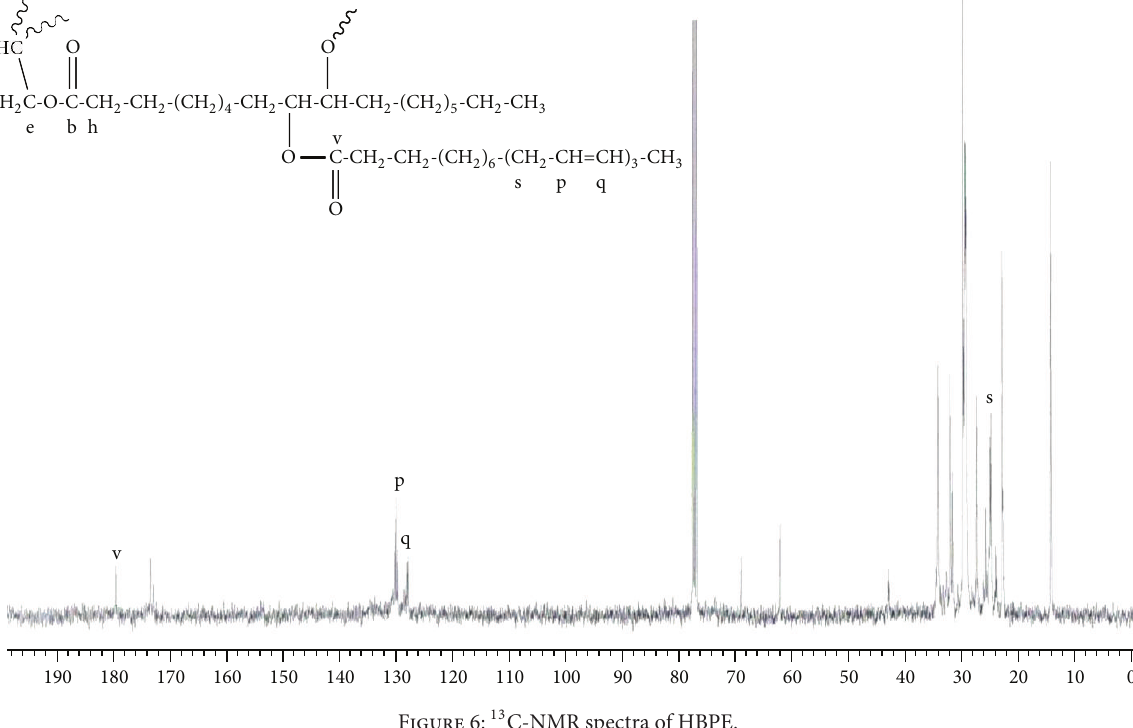
Figure 6: 13 C-NMR spectra of HBPE.